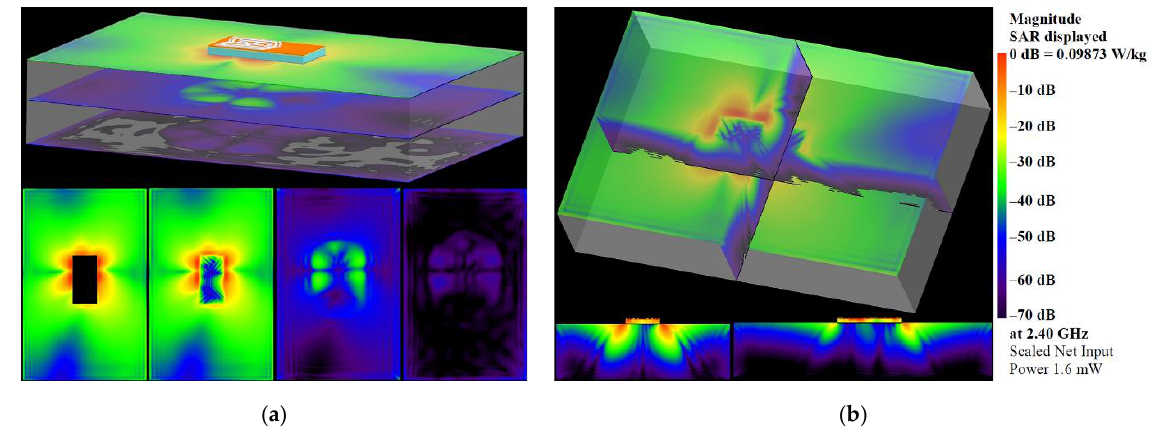
Figure 10. SAR distributions in: ( a ) different planes; ( b ) different cross-sections at 5.47 GHz.